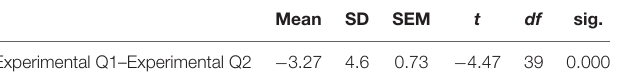
TABLE 2 | Paired samples t -test results on the experimental group’s reflective thinking level.